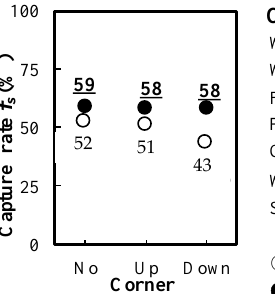
Figure 23. Comparison of the experimental results and numerical analysis results for changes in the supply flow rate.